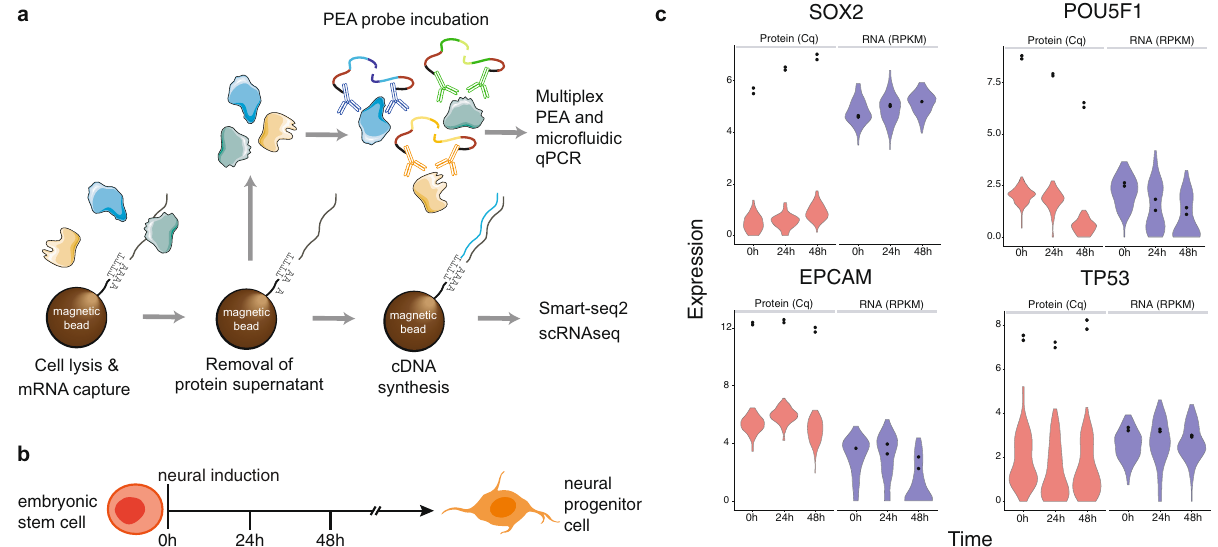
Fig. 1 SPARC pro fi les RNA and intra-cellular protein from the same single cells. a The SPARC procedure. Single cells are isolated and lysed in the presence of oligo-dT conjugated magnetic beads. Following oligo-dT mRNA hybridization, the protein-containing supernatant is removed for subsequent multiplex proximity extension analysis (PEA) and the mRNA is processed using a modi fi ed Smart-seq2 approach. (Protein clip art from Servier Medical Art is used under CC BY 3.0 France.) b Overview of the cellular model analyzed using SPARC. Human embryonic stem cells were analyzed in culture (0 h) and following directed neural induction (24 h and 48 h). c Example mRNA (blue) and protein (red) expression in single cells (violin plots) or replicate 100 cell population control (black dots) measured at 0, 24, and 48 h post neural